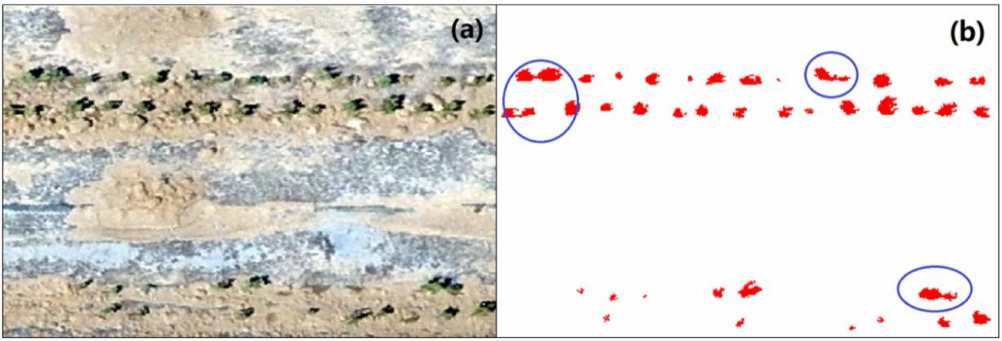
Figure 2. A zoomed-in image of the study region, the true color image ( a ) and classification results of cotton plants ( b